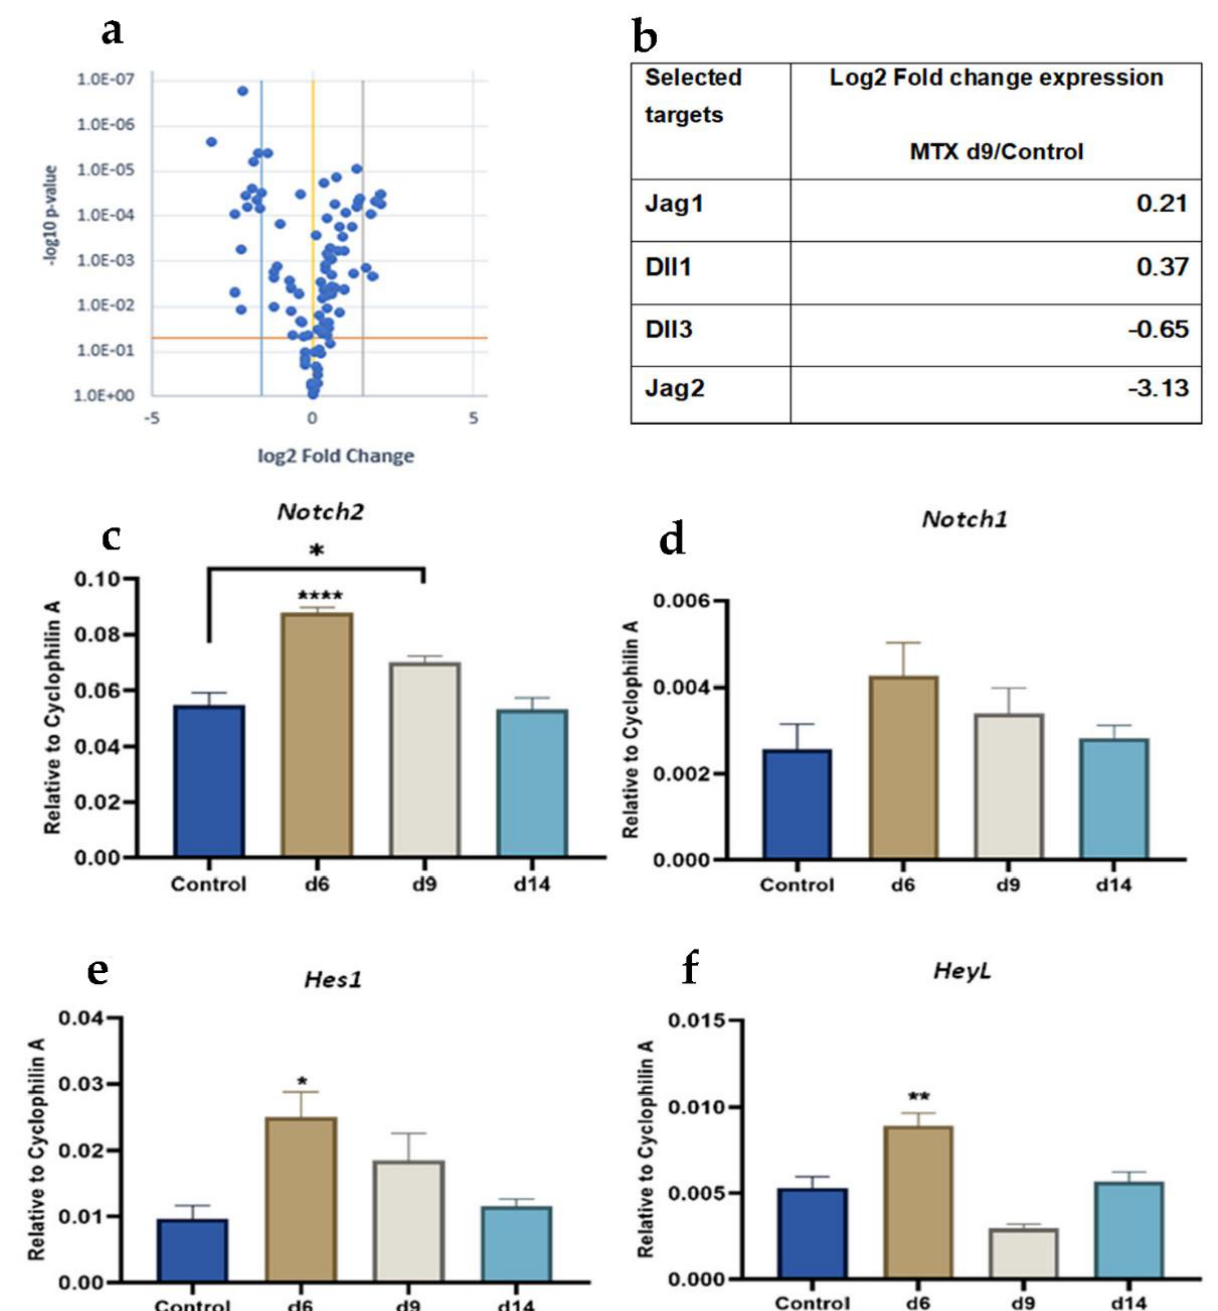
Figure 1. MTX treatment effects on mRNA expression of 92 key factors known important in regulating bone homeostasis and important Notch mediators over the MTX damage/recovery time-course vs. control. ( a ) the volcano plot represents logarithmic fold changes in mRNA expression of 92 factors in MTX day 9 vs. control rats. The yellow line indicates fold changes (2 − ∆∆ Ct ) in gene expression of 1 and the blue and grey colour lines indicate the desired fold-change in gene expression threshold defined as 3 as standard. The orange line indicates the desired threshold for the p value of the t-test defined as 0.05. ( b ) The most significant changes in mRNA expression have been observed in Notch ligand Jag2, which has remarkable logarithmic fold downregulation at day 9 following MTX treatment compared to control group. Quantitative RT-PCR relative gene expression analysis of ( c ) Notch2, ( d ) Notch1, ( e ) Hes1, ( f ) HeyL, using RNA isolated from metaphyseal bone specimens from control and MTX-treated rats; * p < 0.05, ** p < 0.001, **** p < 0.0001.